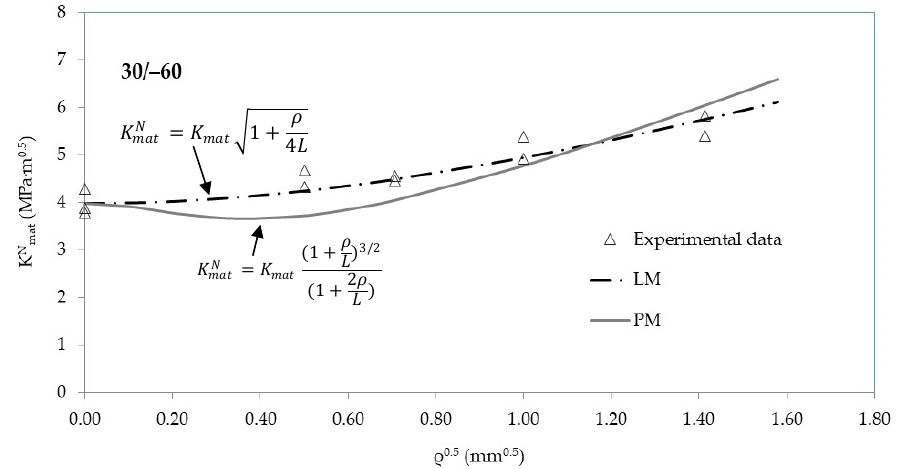
Figure 5. Apparent fracture toughness experimental results in 30 / − 60 raster orientation. Best fit curves provided by the PM and the LM.